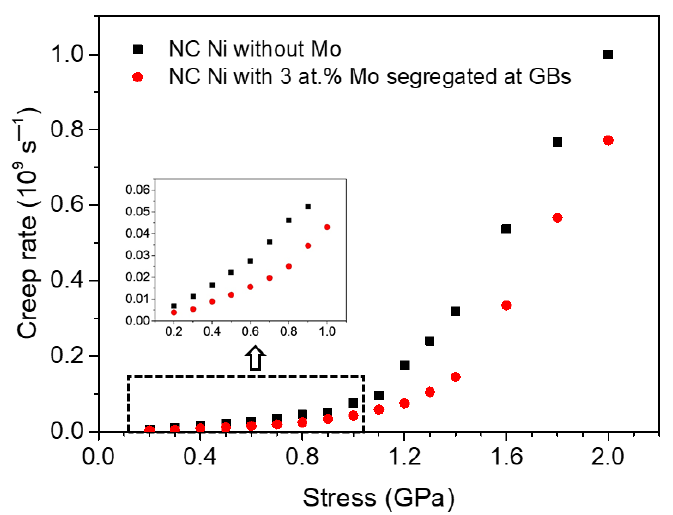
Figure 3. The comparison of the creep strain rate of two groups of NC Ni samples with 𝑑 = 10.9 nm at 1100 K under different applied stresses.